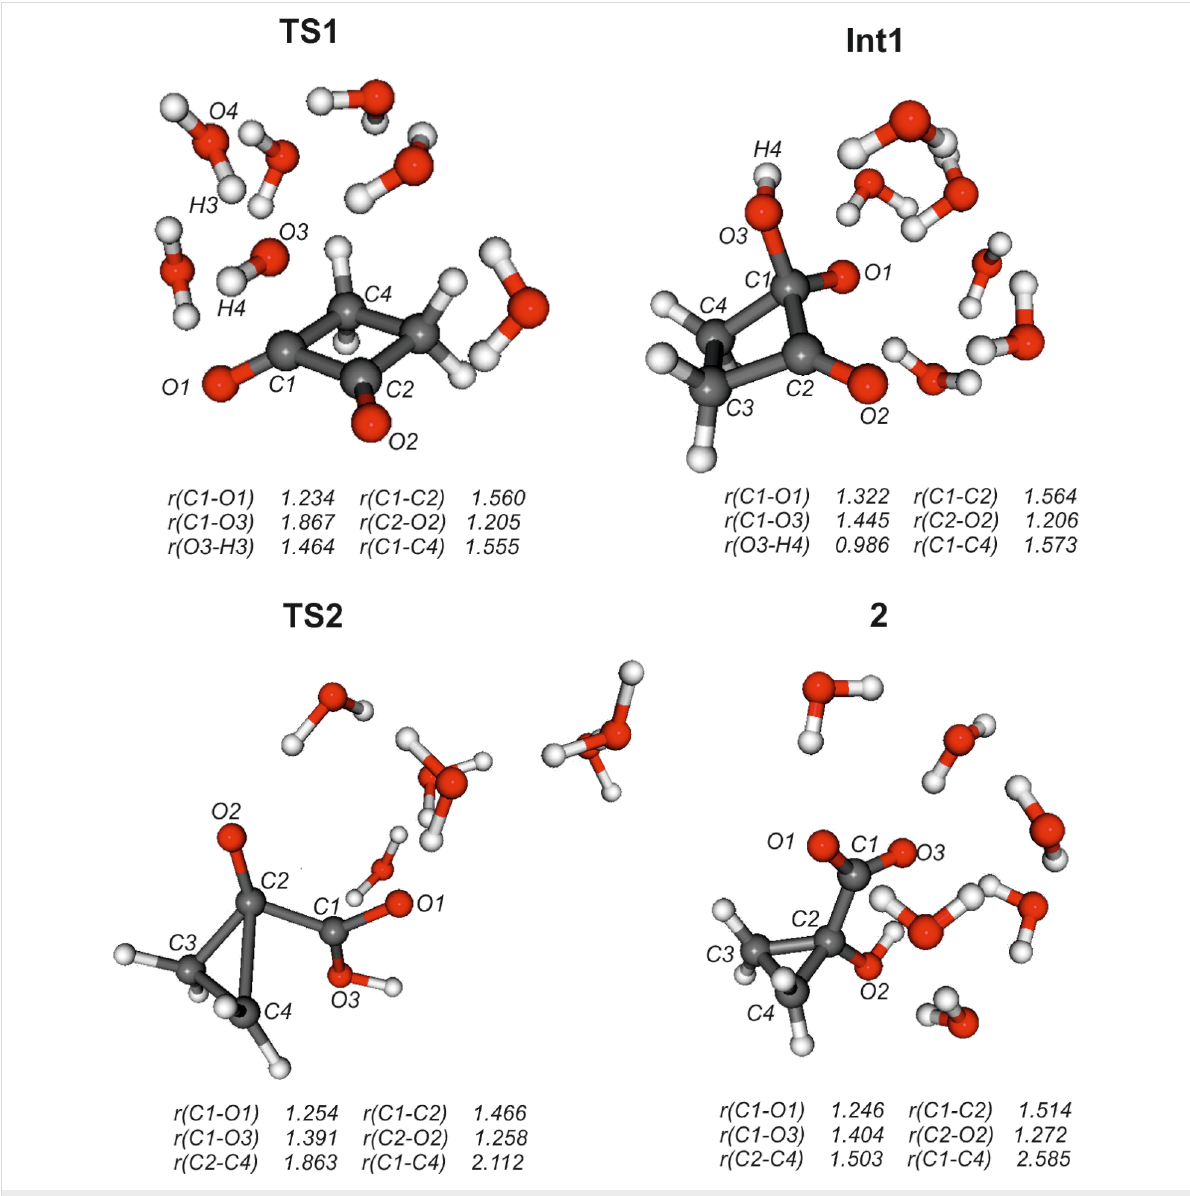
Figure 2: M06-2X/6-31+G(d,p) calculated structures of stationary points along the benzilic acid type rearrangement. Distances are given in angstroms (Å).